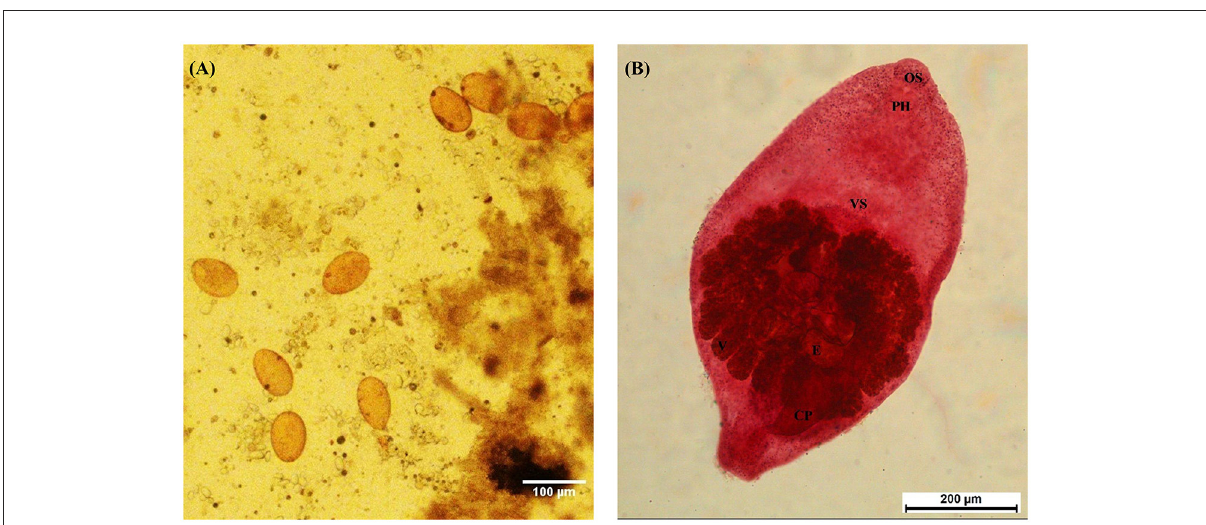
FIGURE1 Morphology of Prohemistomum vivax eggs and adults recovered from experimentally infected pigeons. (A) P. vivax eggs isolated from pigeon feces by the sedimentation method. The scale bar was 100 µ m. (B) Adult P. vivax stained with Semichon’s acetocarmine stain at 100